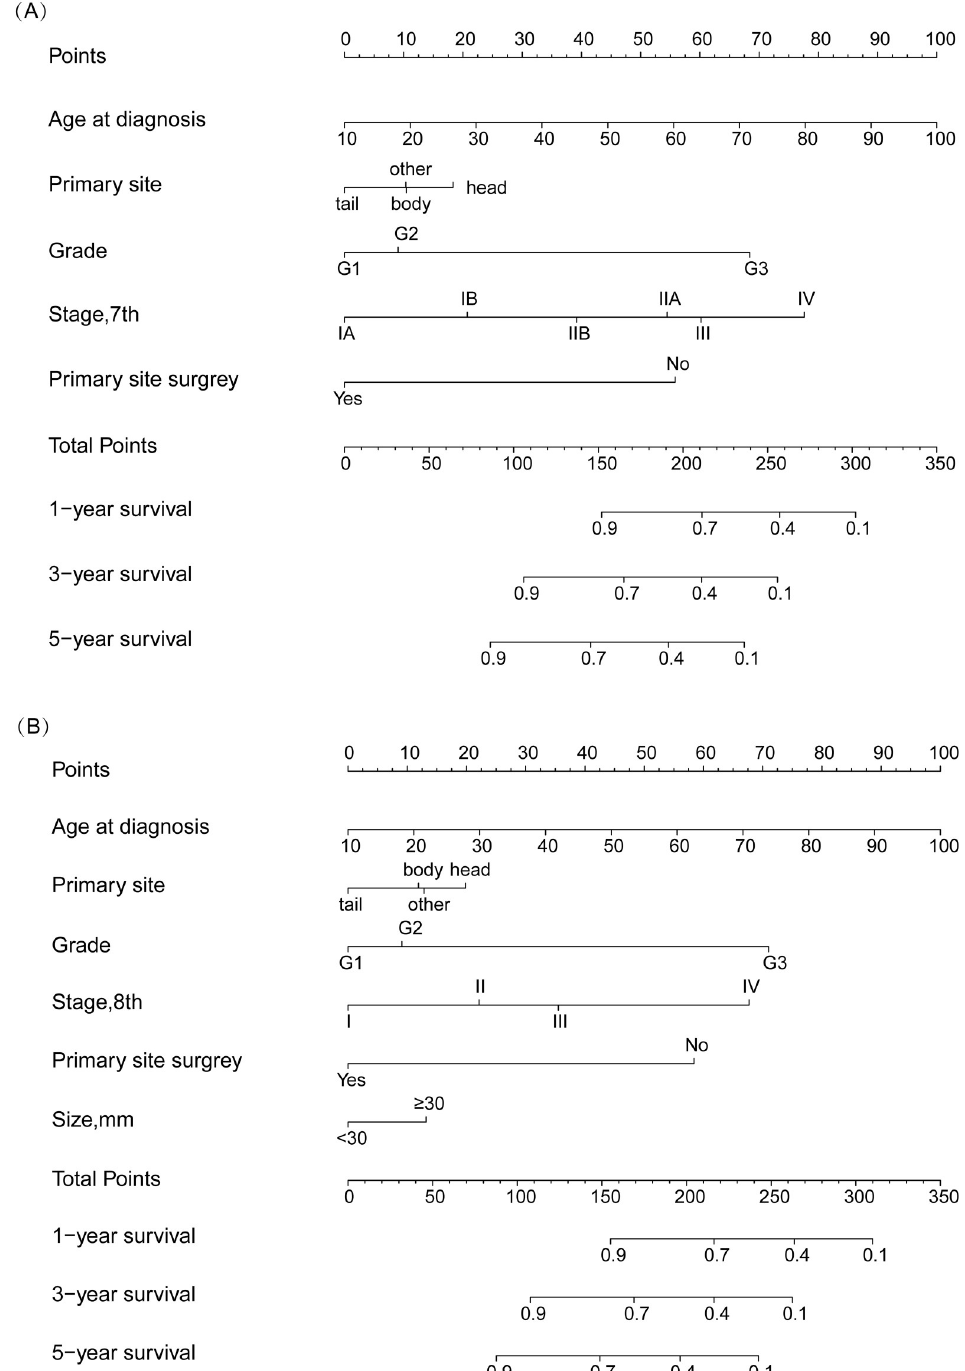
Fig 1. Nomograms for predicting the 1,3- and 5-year OS of NF-pNET patients (A: NomogramA; B: NomogramB).